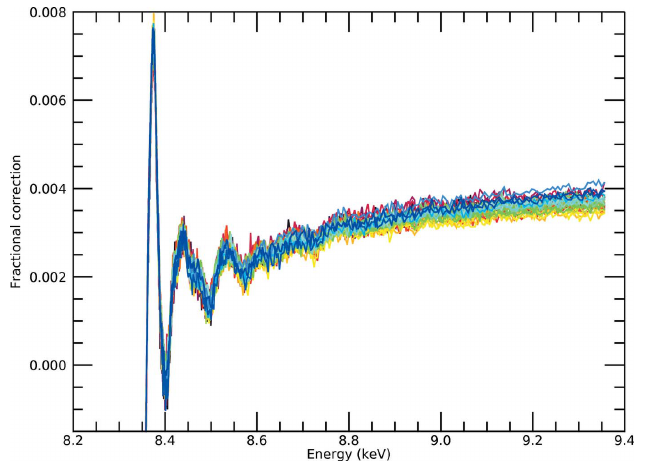
Figure 7 Fractional correction after first-order Taylor expansion correction [equation (8)] for the i -pr data set. The base level is about 0.4%, the white line peak is about 0.8% and the oscillations of the first few peaks are of the order of 0.2–0.3%, just as expected from the ratio. The inversion appears robust for all pixels to below a 0.1% level.